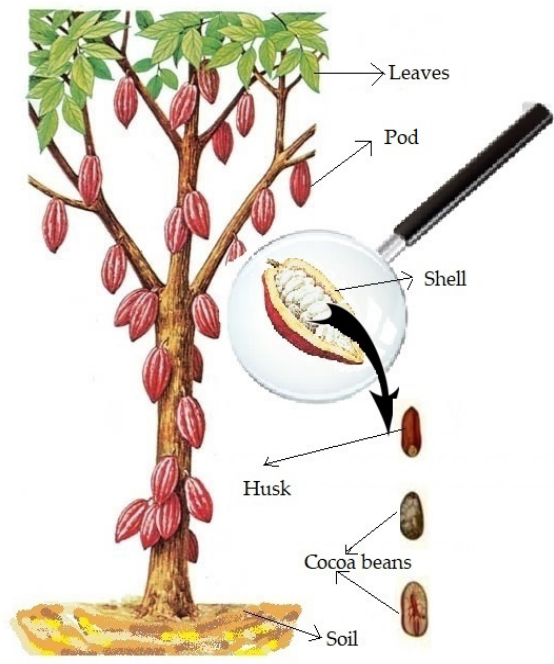
Figure 2. Parts of cocoa plant sampled.